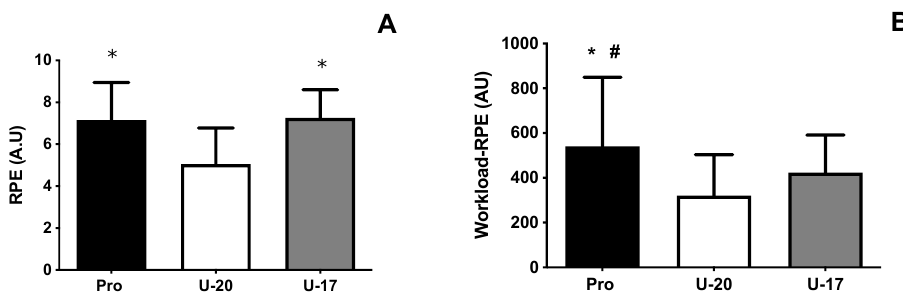
Figure 2. ( A ) RPE and ( B ) Workload-RPE in Pro, under-20 (U-20), and under-17 (U-17) age groups.